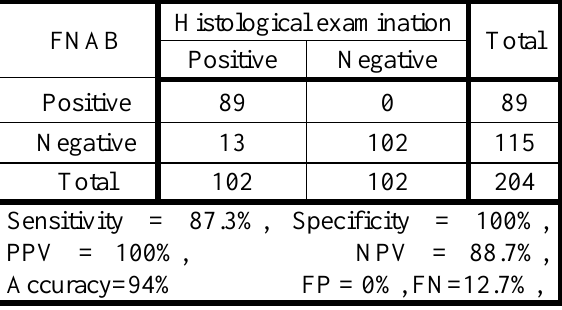
The complete sensitivity